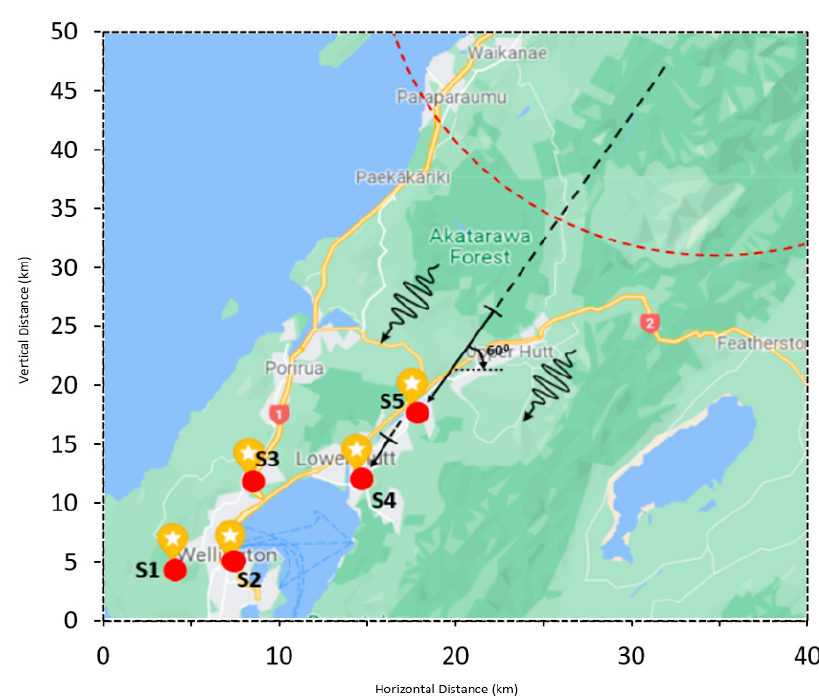
Figure A2. Scenario 2.